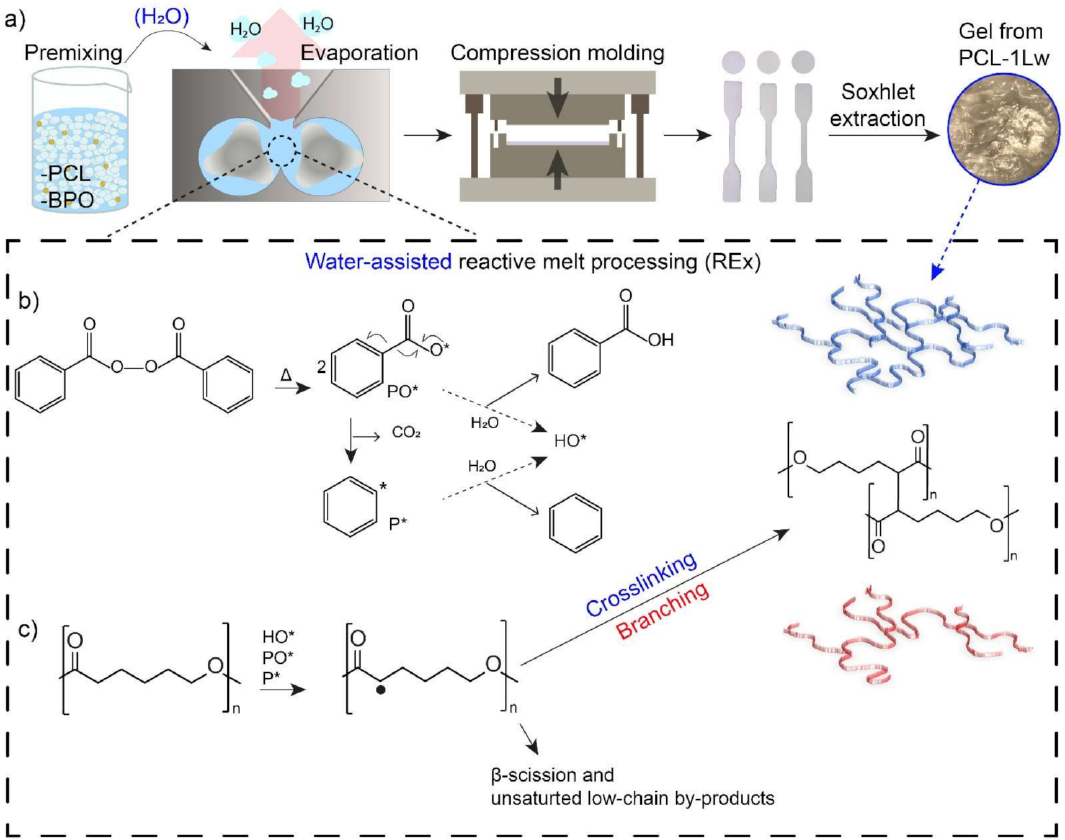
Figure 1. ( a ) Scheme of sequential steps: REx with or without water, compression molding of test specimens and Soxhlet extraction to recover gel fractions. The photo refers to insoluble fraction of PCL reacted with 1 wt.% peroxide during water-assisted REx. Schematics of ( b ) peroxide activation and reactions with water and ( c ) reaction